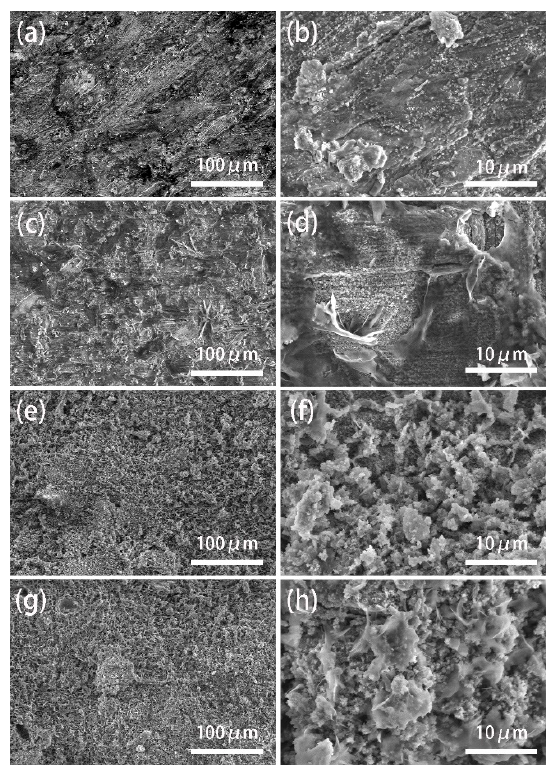
Figure 3. SEM images of the sample surfaces with different heating temperature: ( a , b ) 365 °C; ( c , d ) 375 °C; ( e , f ) 385 °C; ( g , h ) 395 °C.